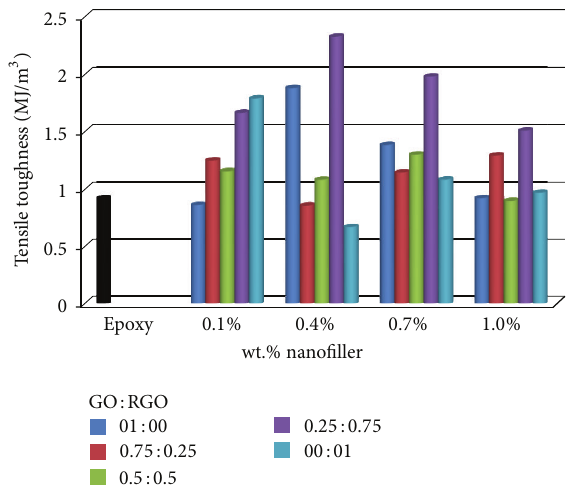
Figure 7: Tensile toughness of samples reinforced with nanomate-